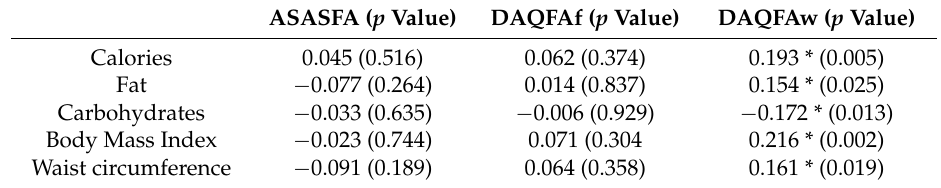
Table 3. Correlations between Acculturation Scale, Dietary Acculturation Scale (Filipino, Dietary Acculturation Scale (Western), Dietary Intake and Anthropometric